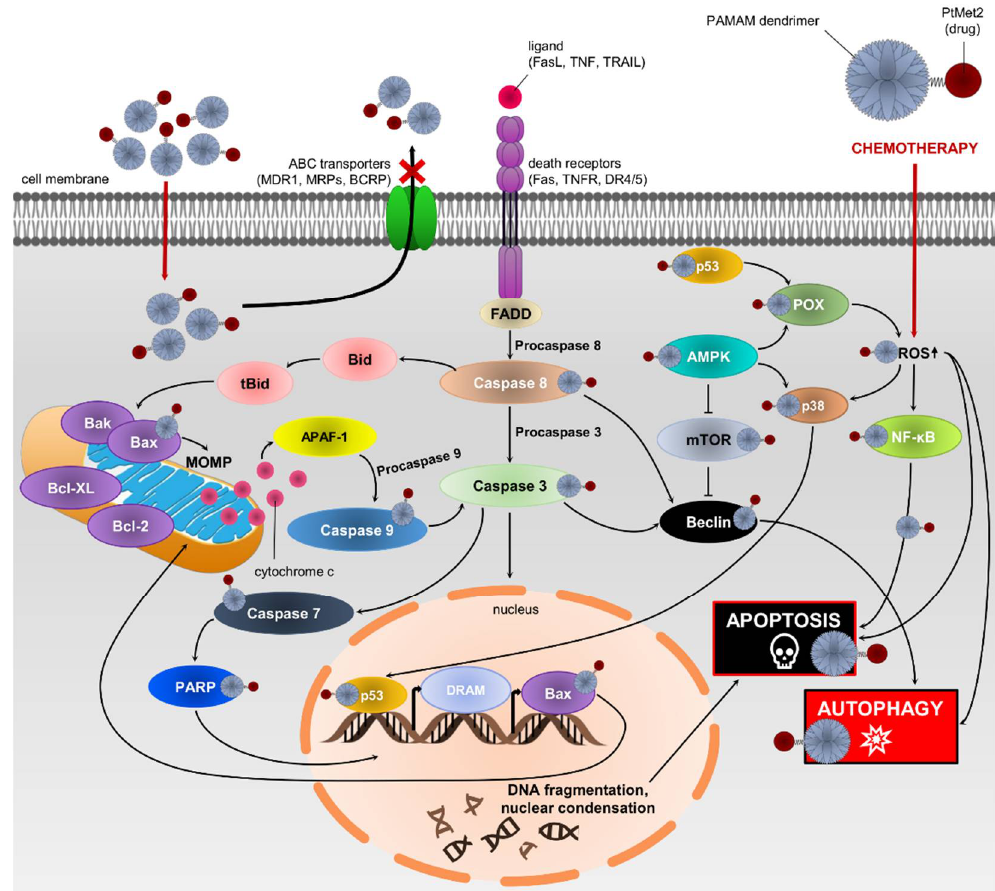
Figure 19. Schematic representation of possible anticancer mechanism action of PtMet2–PAMAM in MCF-7 and MDA-MB-231 cells.